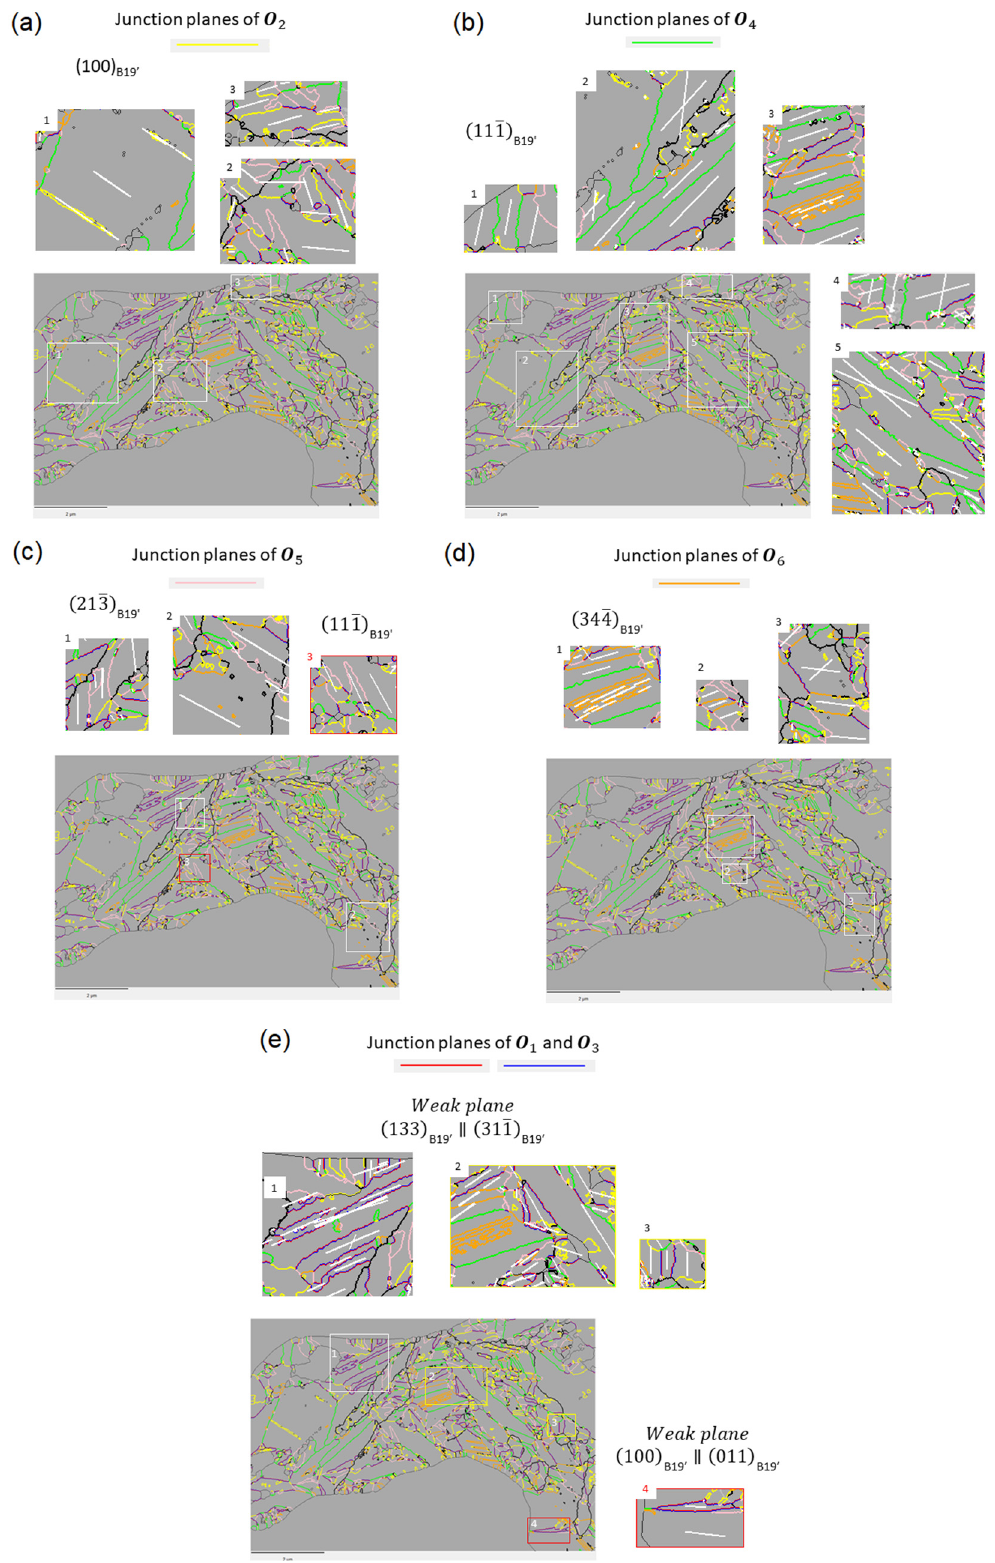
Figure 6. Traces of the junction planes predicted by the CT for the operators ( a ) O 2 , ( b ) O 4 , ( c ) O 5 , ( d ) O 6 ( e ) O 1 and O 3 . The comparison for each pair of B19 (cid:48) variants is visually made by considering whether the traces are parallel to the grain boundaries. Good agreement was found for most of the boundaries that were considered.